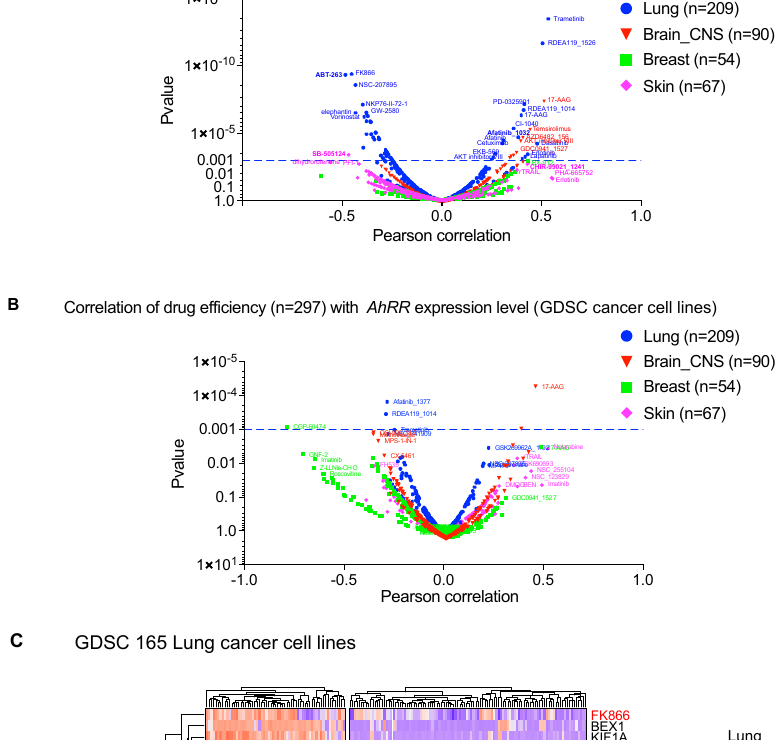
Correlation of drug efficiency (n=297) with AhRR expression level (GDSC cancer cell lines)